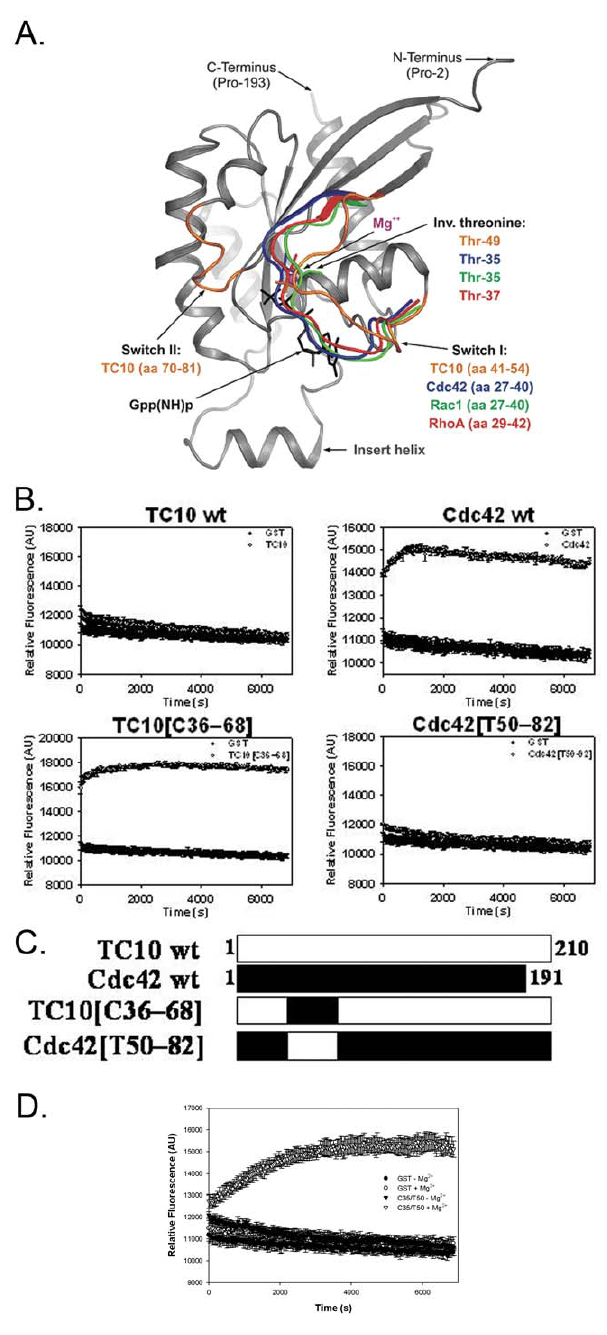
Figure 3. TC10 and Cdc42 are structurally divergent in the magnesium binding pocket. A) Structural comparison of TC10 with Cdc42, Rac1 and RhoA. The structure of the C-terminal truncated, active GppNHp-bound TC10 (PDB code 2ATX) is shown, which mainly differs in the conformation of the Switch I region (orange) as superimposed on the Switch regions of Cdc42 (1NF3; blue), Rac1 (1MH1; green) and RhoA (1A2B; red). Switch II, insert helix, GppNHp (a non-hydrolyzable GTP analog) and the respective invariant threonine of in the Switch I are highlighted. The latter normally contact the magnesium ion (sphere magenta), but this is not the case for TC10. B) Binding of mantGDP to TC10/Cdc42 chimeras (solid circles) in the absence of magnesium compared with a GST control (empty circles). Values shown are mean with standard error bars. C) Schematic of chimeras of TC10 and Cdc42 with black bars indicating Cdc42 and white bars indicating TC10. D) Rescue of mantGDP binding of the Cdc42[T50-82] construct